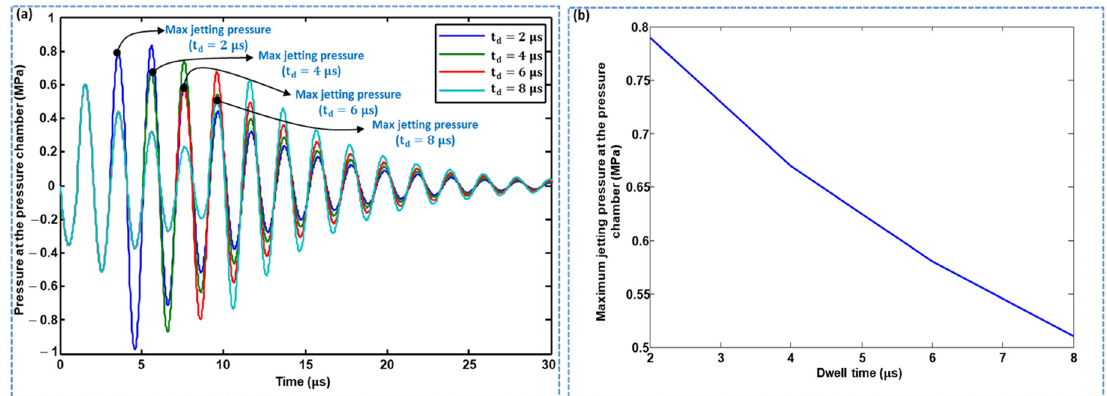
Figure 4. Effect of dwell time of the standard waveform on jetting pressure at the pressure chamber: ( a ) pressure profiles with various t d , and ( b ) e ff ect of dwell time on maximum jetting pressure.